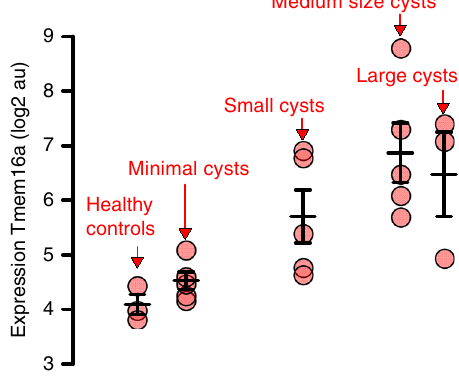
Fig. 9 Expression of TMEM16A correlates with cyst size in ADPKD. Reanalysis of the public data set (GSE7869) from a global gene pro fi ling study on renal cysts reported by Song et al. 31 . The data set comprises microarray expression data from cysts of different sizes from n = 5 PKD1 - patients and from n = 3 kidneys of healthy patients. Reanalysis was performed using the Transcriptome Analysis Console (Thermo Fisher).